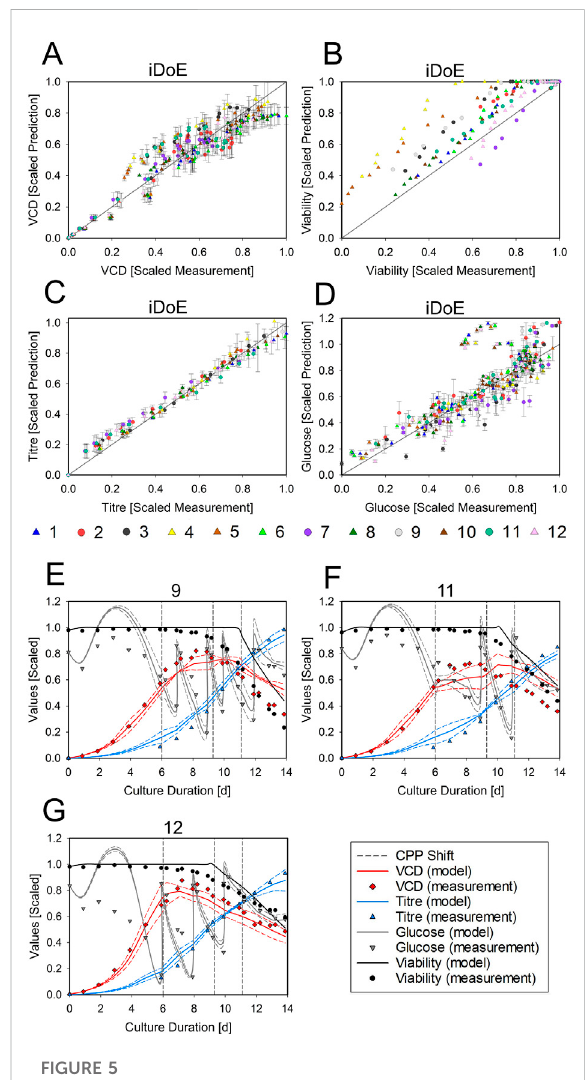
FIGURE 5 Performance of the Averaged HM in Predicting the Outputs of the iDoE and of Independent Validation Data The scatter plots display the scaled measured data points against the scaled HM predictions for VCD (A) , viability (B) , titer (C) , and glucose (D) , including the least-square lines. Colors represent the bioreactors. The symbols group into growth phase settings (circle = platform; triangle = growth-optimized). For the time-resolved representation of bioreactor 9 (E) , 11 (F) , and 12 (G) , the scaled measured data points for VCD (red diamonds), viability (black circle), titer (blue triangle), and glucose (grey downward triangle) are overlayed by the scaled predictions of the averaged HM (solid lines) and the PI (dashed lines) in the respective colors. The timing of input setpoint changes is indicated as dashed grey